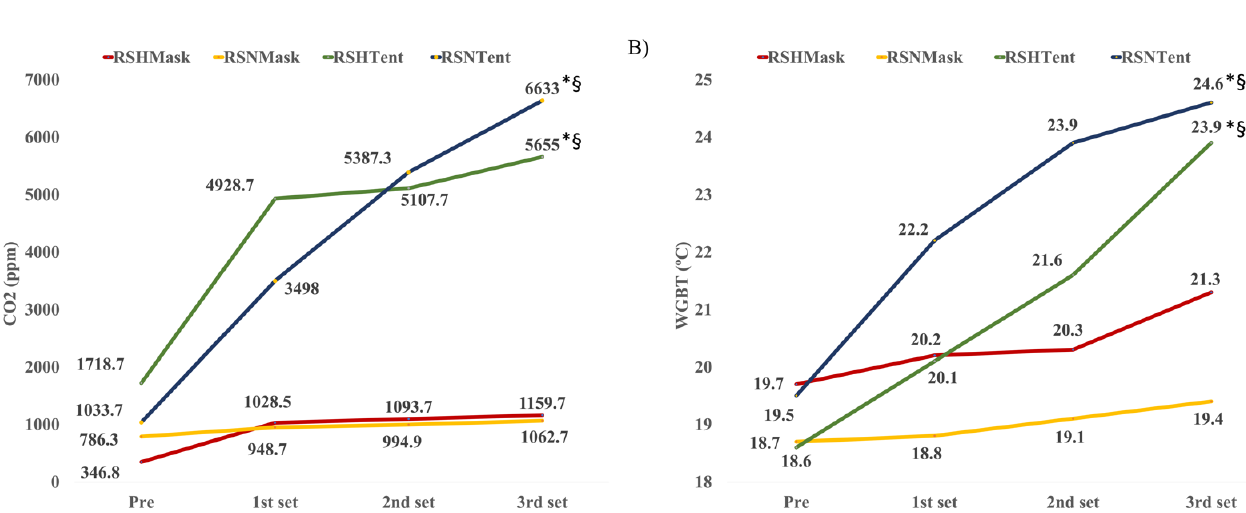
Table 1. Changes in cardiovascular responses due to repeated-sprint workout in normoxia and hypoxia. Repeated-Sprint